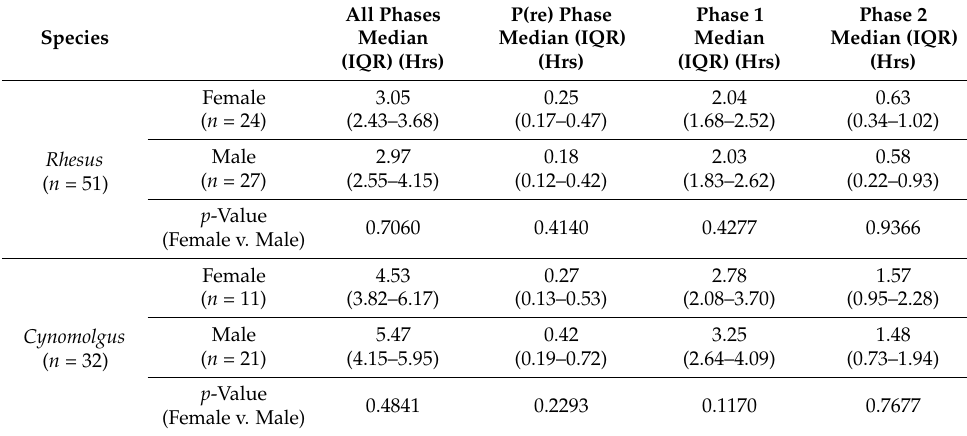
Figure 3. Training Completion Time by Temperament in Cynomolgus Macaques. Kaplan–Meier time-to-event analysis comparing the time required to successfully complete all phases and individual phases of the training paradigm between inhibited and exploratory cynomolgus macaques. There were no significant differences between groups for completing ( a ) all phases (Log-rank χ 2 = 0.41 (df = 1), p = 0.52), ( b ) P-Phase (Log-rank χ 2 = 0.60 (df = 1), p = 0.45), ( c ) Phase-1 (Log-rank χ 2 = 0.02; (df = 1), p = 0.88), or ( d ) Phase-2 (Log-rank χ 2 = 0.63 (df = 1), p = 0.43). Table 5. Training Time Summary by